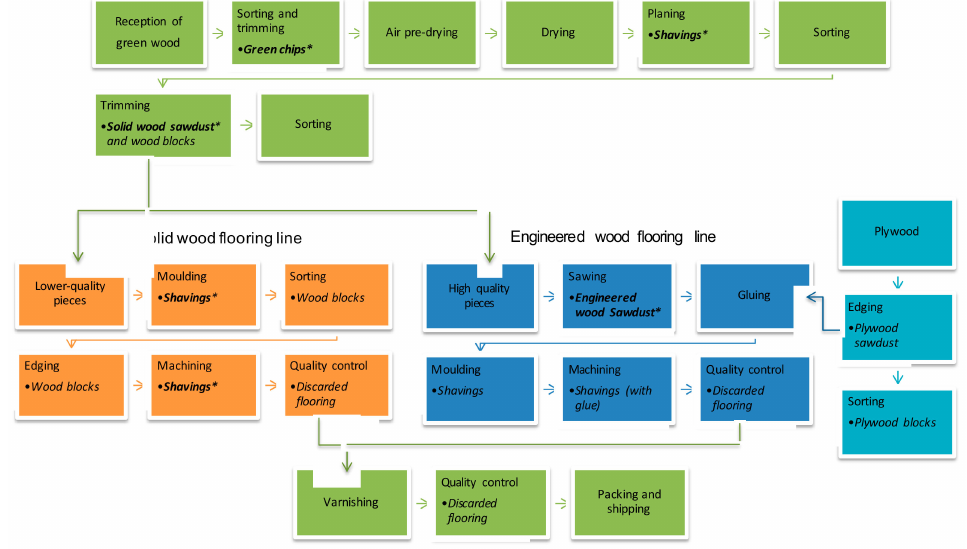
Figure 1. Production lines for the solid and engineered wood flooring. Residues from each process are indicated in italics. Residues collected for pelletizing are indicated with